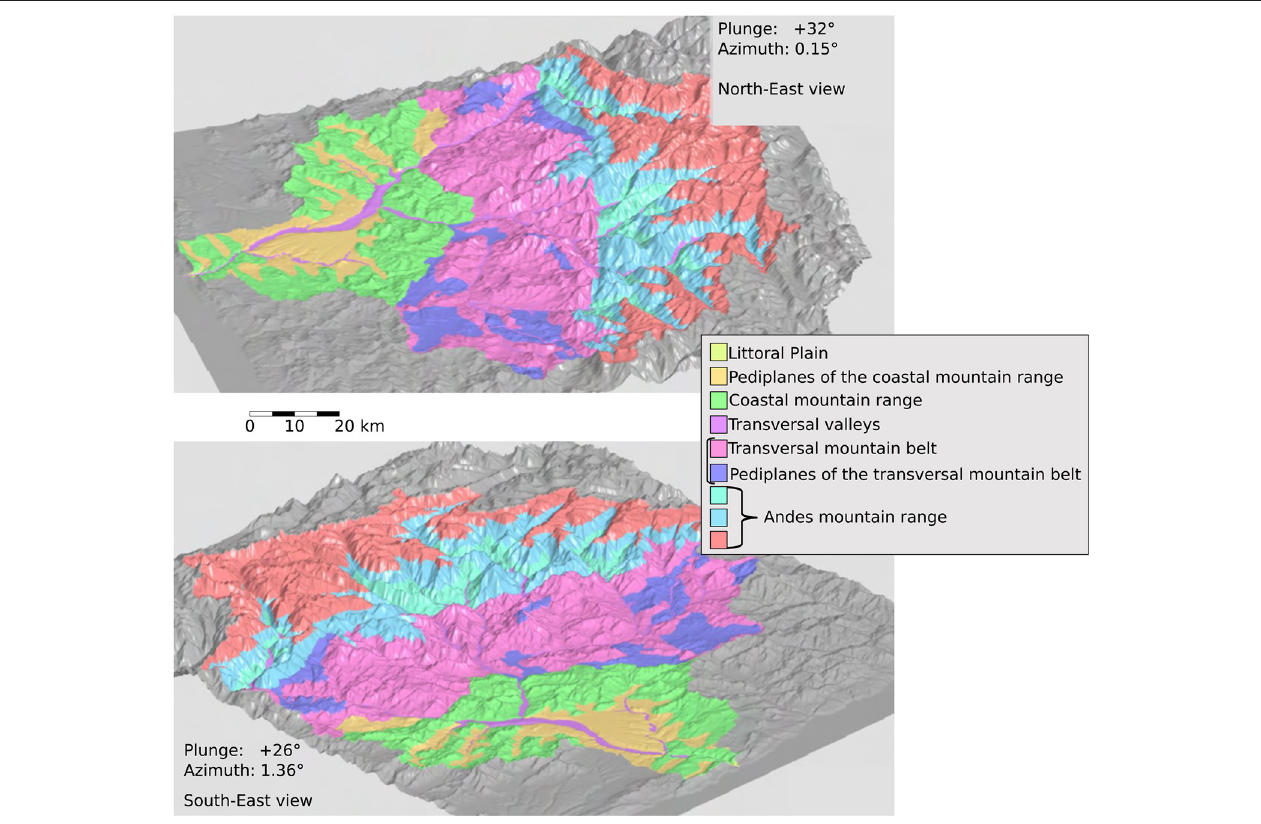
FIGURE 2 | Perspective views of the Limarí river catchment topographic relief. The geomorphological macro-units defined in Luis et al. (2019) are show in different colors. Figure adapted from Luis et al.